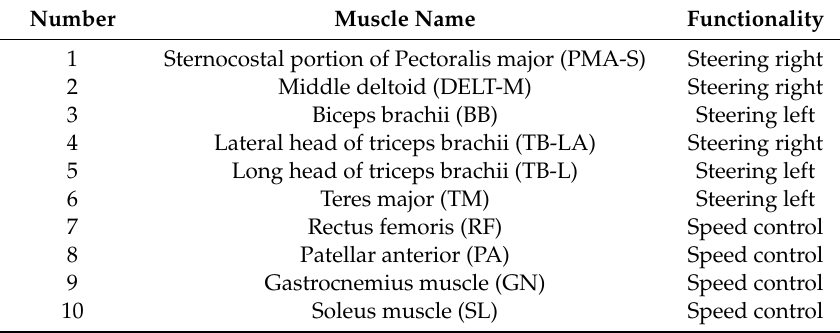
Figure 5. Measured Muscles and the electrode placements. ( a ) arm muscles, ( b ) leg muscles. Table 3. Measured muscle groups.